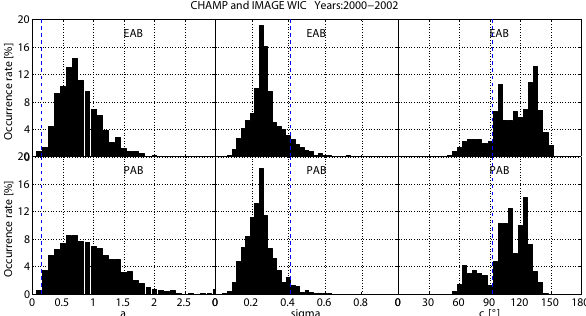
detections between CHAMP FAC and BAS auroral boundaries cat- alogue. The blue dashed lines mark the threshold values of the pa- rameters used in our